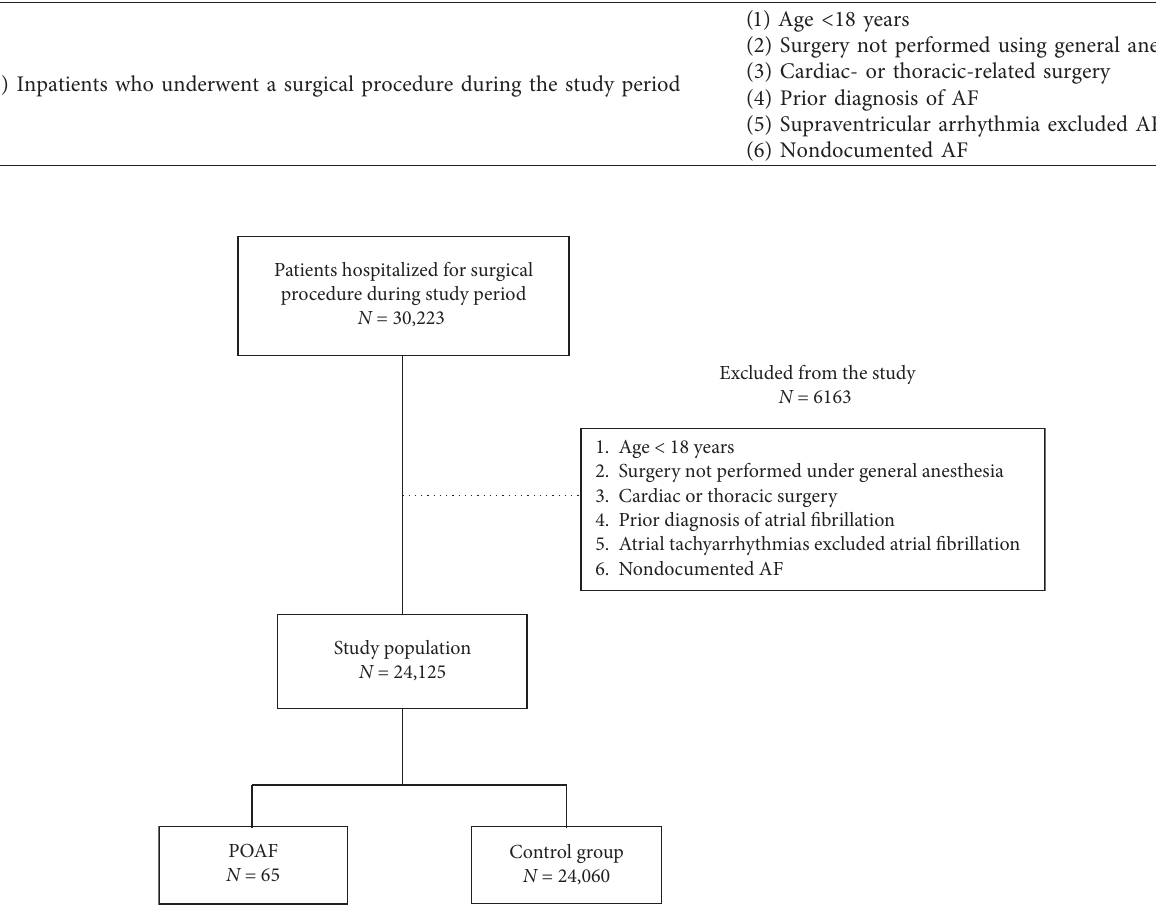
Figure 1: Schematic illustration of the study design and patient-selection criteria. Table 2: Baseline clinical characteristics among study groups.